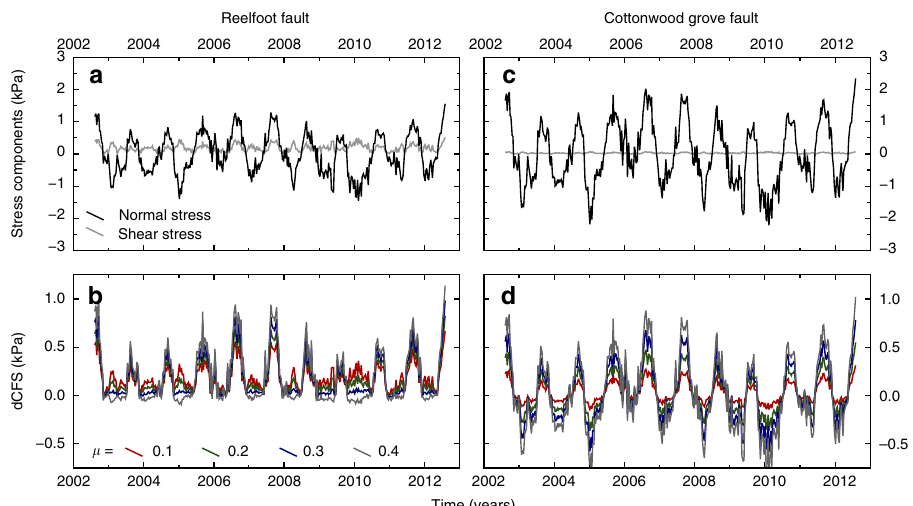
Fig. 7 Stress variations for the two fault systems. The top two panels ( a , c ) show variations in shear (grey) and normal (black) stress resolved on to the fault plane. The lower two panels ( b , d ) show changes in Coulomb stress calculated from the normal and shear stresses above, using various coef fi cients of friction from 0.1 to 0.4. The plot shown in Fig. 6 assumes a coef fi cient of friction of 0.4. The left two panels show values calculated for the Reelfoot thrust fault, and the right two panels show the same values calculated for the Cottonwood grove strike-slip